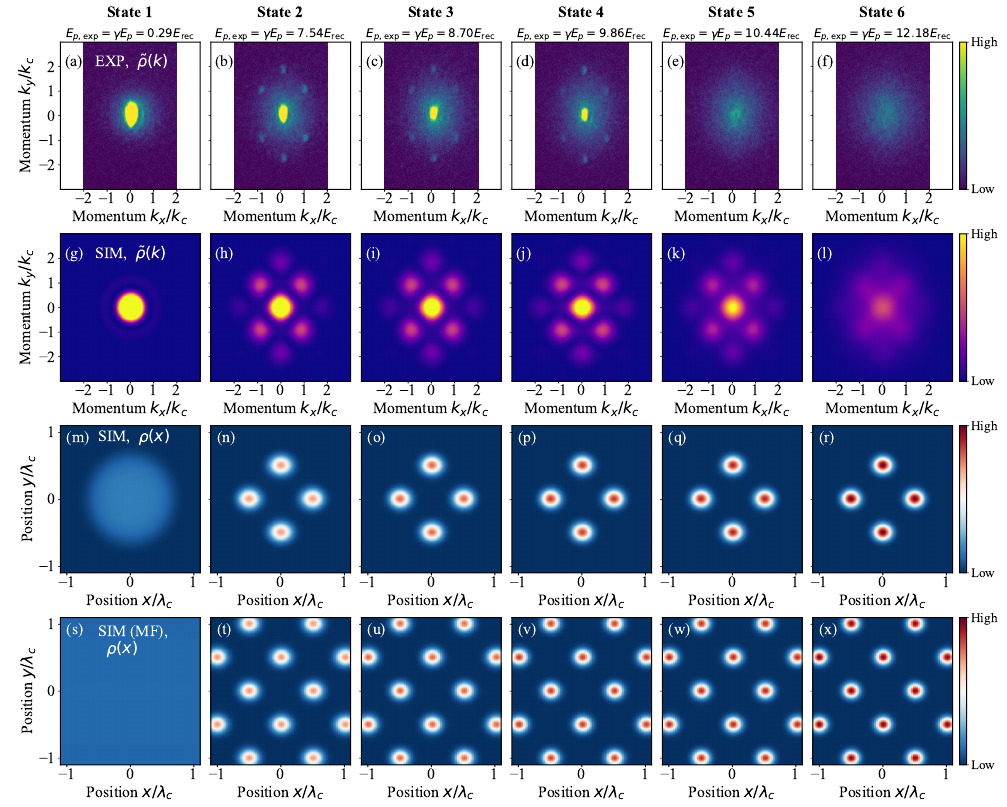
Figure 5: (a-f) Experimentally measured and (g-l) simulated momentum space den- ) , as well as simulated real space density distributions sity distributions ˜ ρ ( k , k x y ρ ( x , y ) of the four-well model for six different parameter sets. The chosen states range from normal BEC state to SSF states to SMI states. (s-x) For comparison, ρ ( x , y ) of the full two-dimensional model [ cf. Eq. (9) ] simulated in the mean-field limit. To facilitate the comparison with panels (m-r), we zoom around the trap cen- ter and choose only the odd configurations. These states are simulated or measured = − 2 π × 30 kHz and at different pump strengths E at ∆ , which correspond re- p eff spectively to the points 1 to 6 indicated in Fig. 6(b). In panel (m) the BEC is highly localized at the trap center due to the tight trap [ Eq. (12b) ] , whereas in panel (s), the BEC has an almost uniform non-zero distribution in the center of the trap due to the relatively loose harmonic